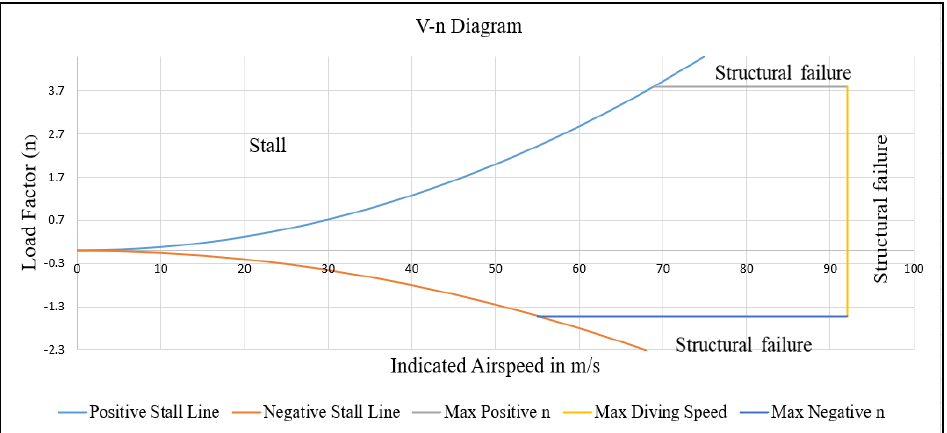
Figure 34. V–n diagram for the present aircraft.